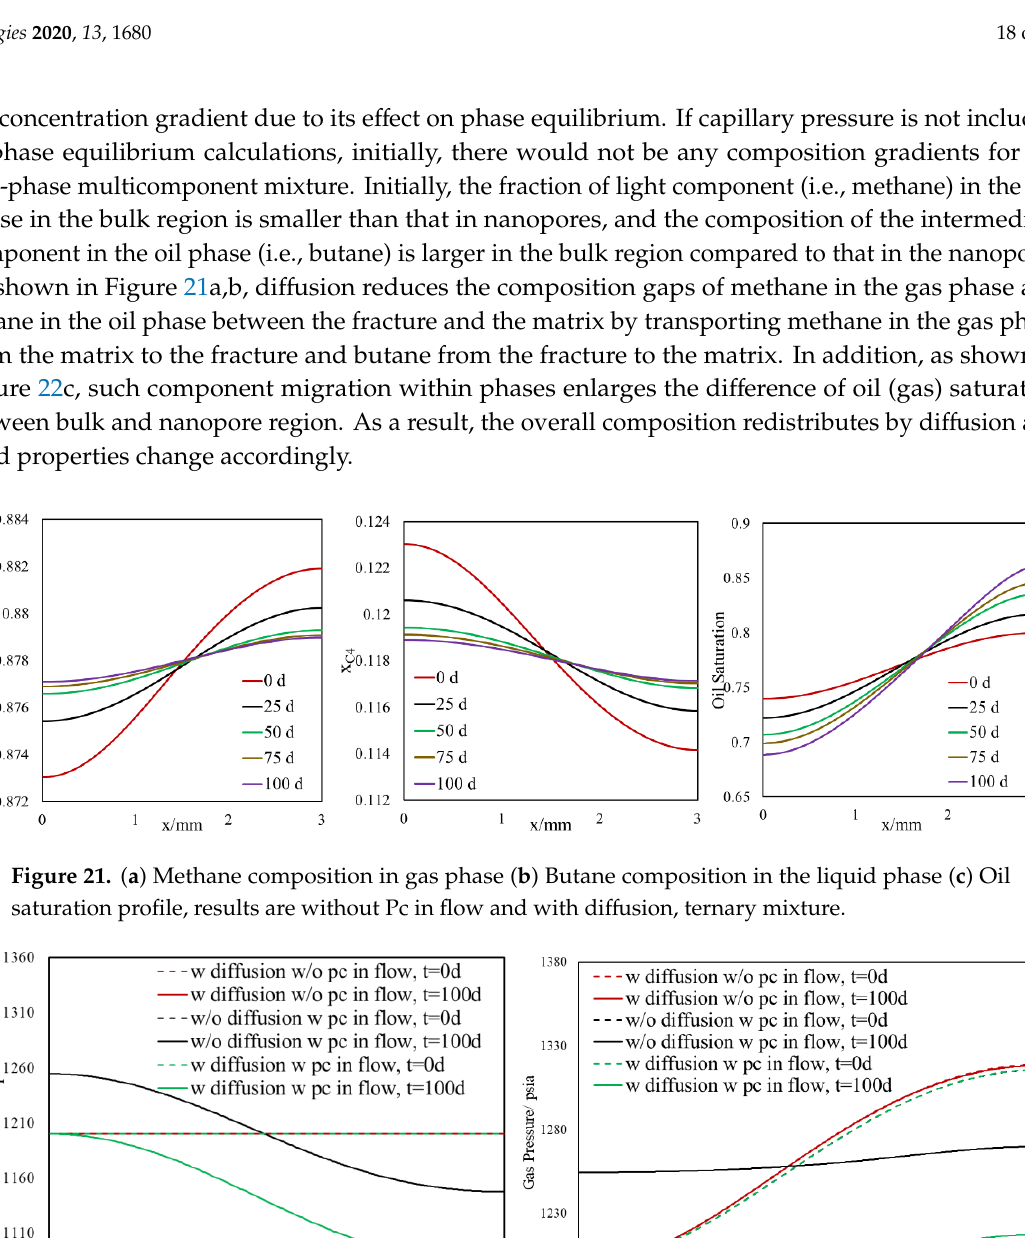
Figure 22. Oil and gas pressure distribution at initial time step (t = 0 d) and final time step (t = 100 d) for different models, ternary mixture, 1200 psi.